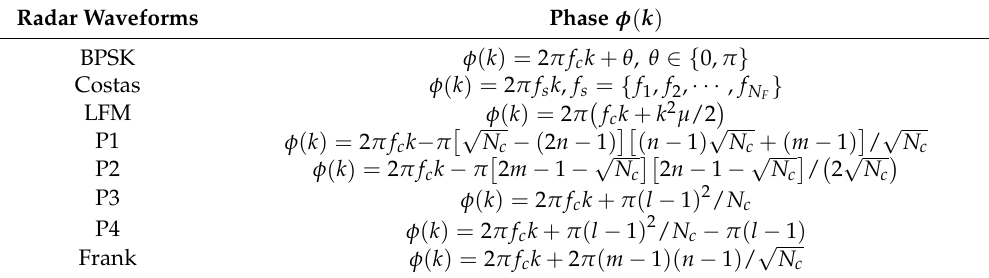
Table 1. The phase of 8 radar